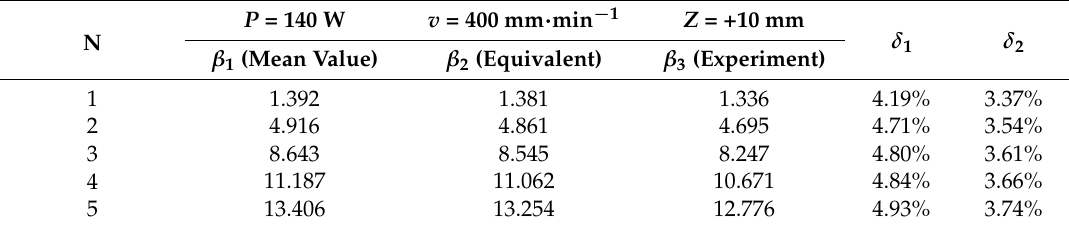
Table 7. Comparison of bending angle and error between the mean value method and the equivalent method with different scanning